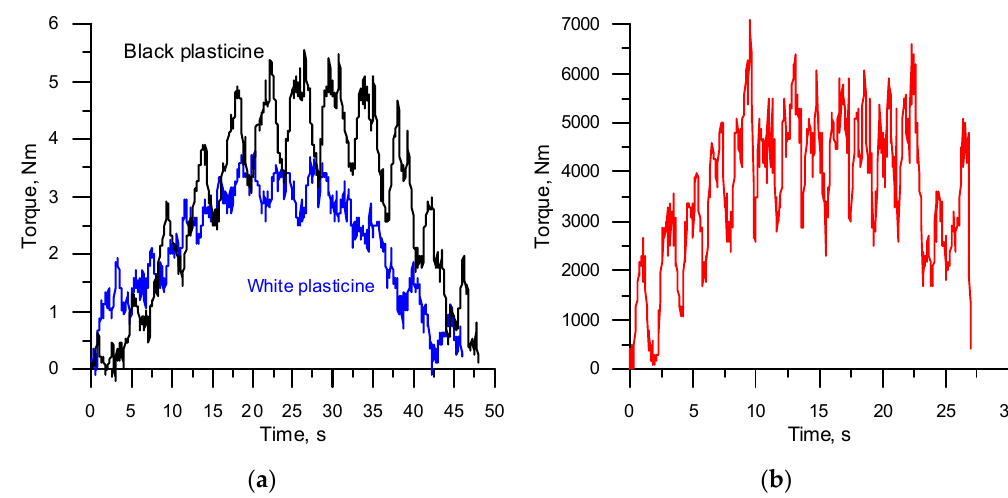
Figure 13. Torque of the roll registered during ( a ) helical rolling of balls from model material; ( b ) helical rolling of C60 grade steel balls of 57 mm diameter.